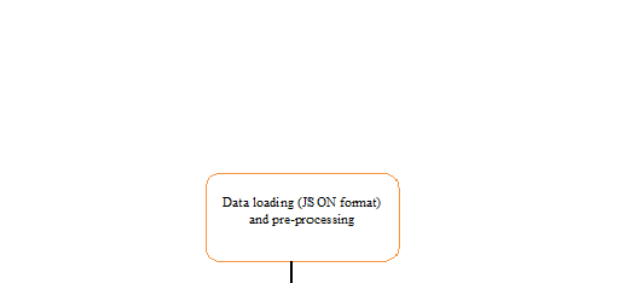
Table 1. The above tabulated value represents overall Efficiency Measure with Tensorflow from a document of 20 samples.